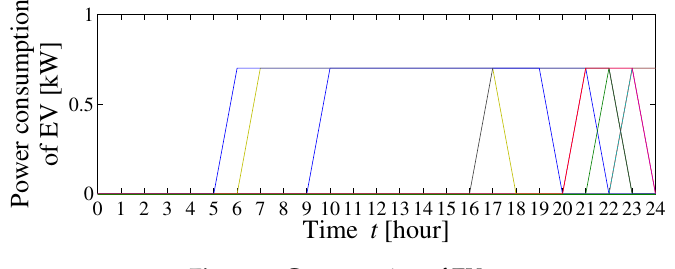
Figure 5. Consumption of EV.